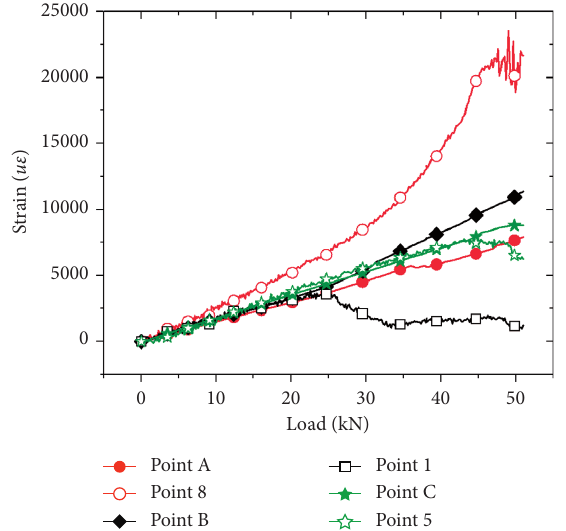
Figure 7: Comparison of strain values between gauge measure- ments and DIC results.